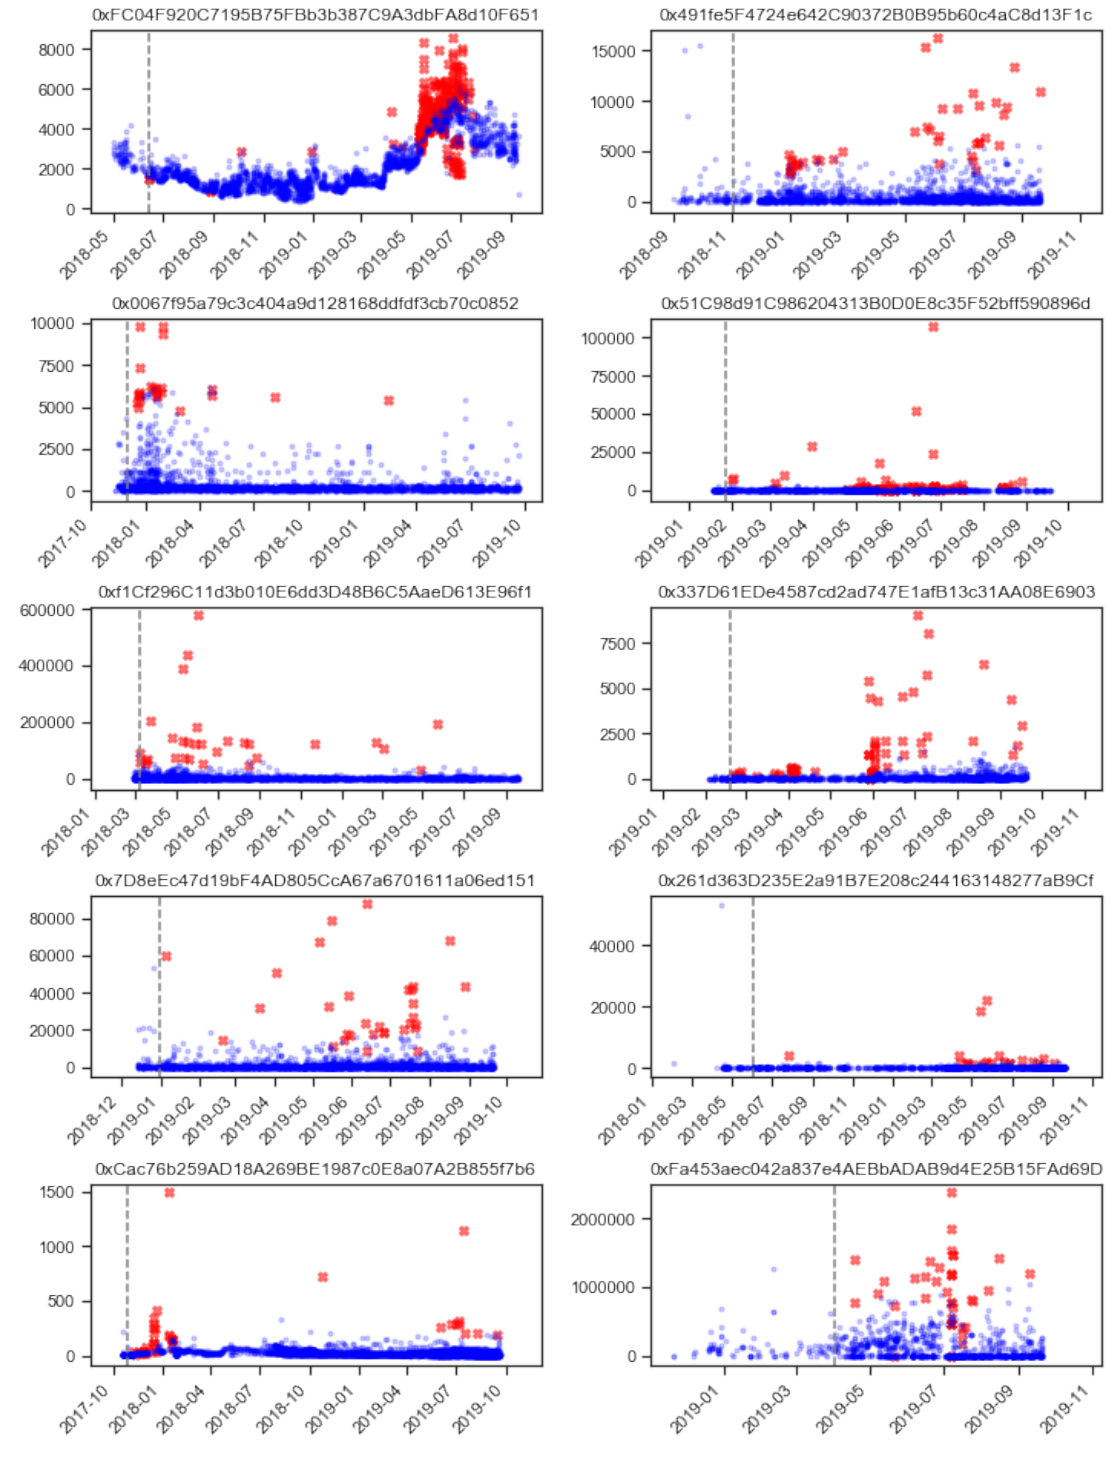
Figure 4. Transactions with annotated anomalies (red X) for all ten Ethereum addresses in the